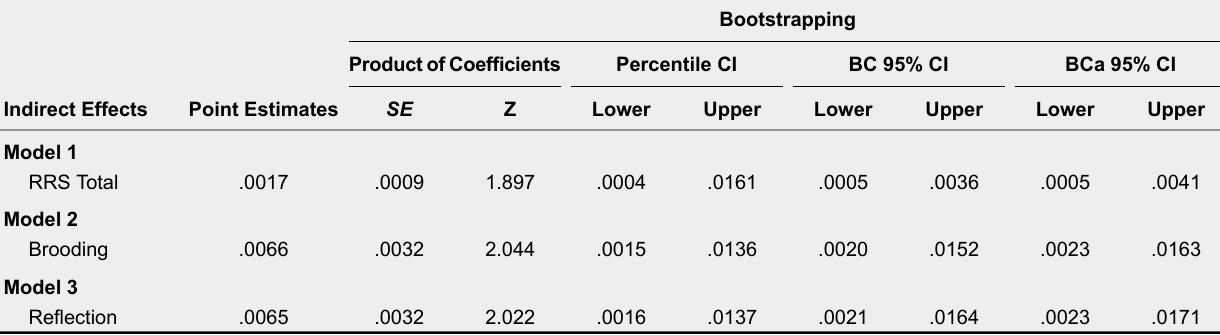
Indirect Effects of Ruminative Cognitive Styles on Suicidal Ideation Through Self-Defeating